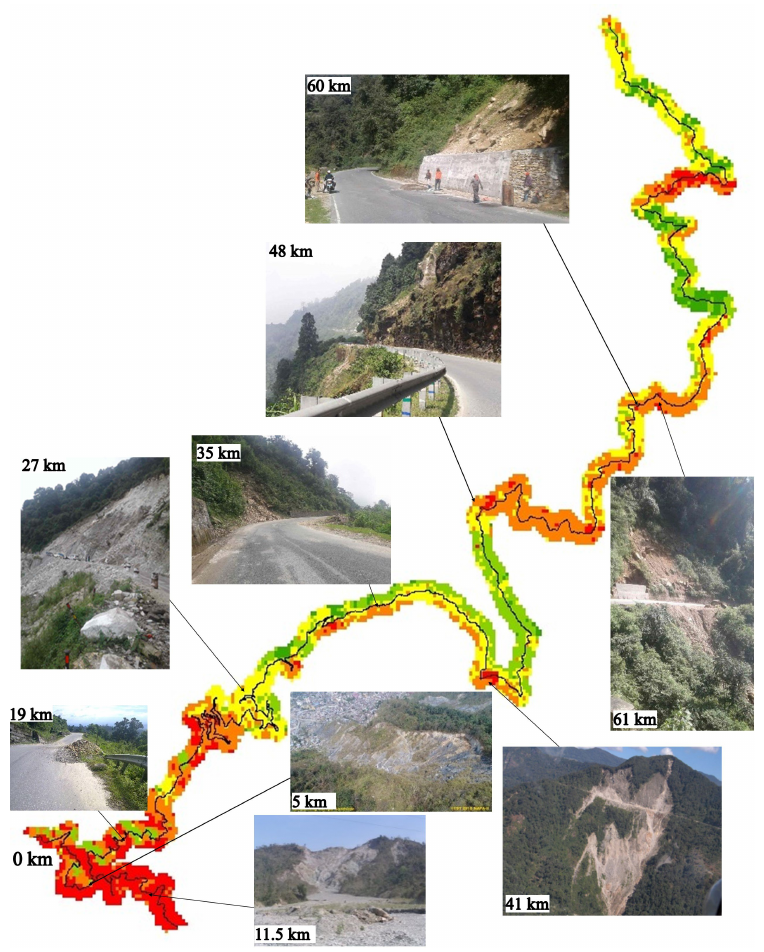
Figure 10. Landslides along the AH48 superimposed on the landslide susceptibility map (LSM) produced with the IV